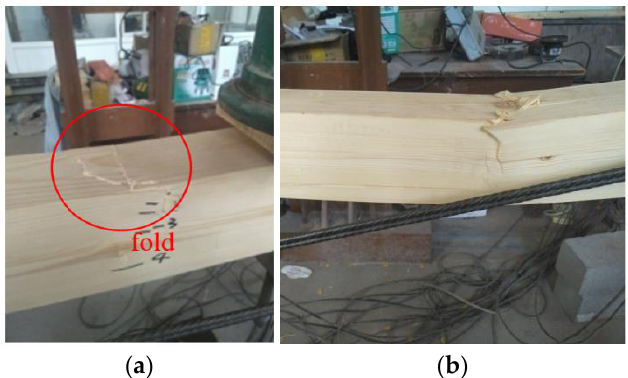
Figure 10. Compressive failure at the beam top. ( a ) the fold at midspan; ( b ) the fold at 1/4 beam.